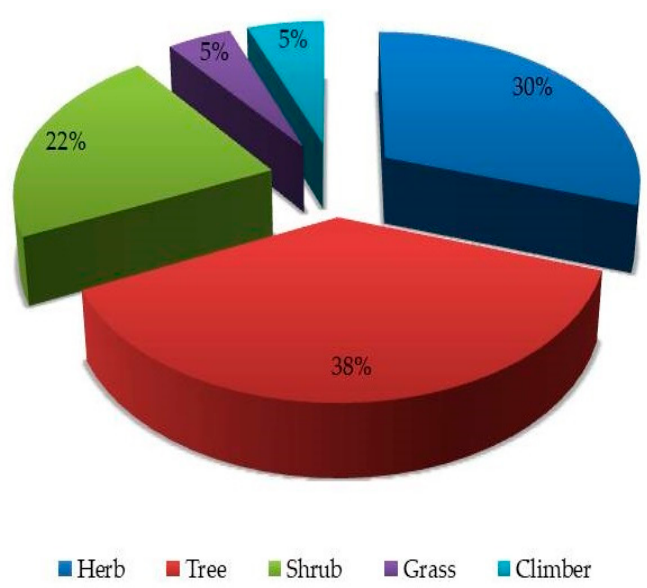
Figure 5. The growth form of medicinal plants documented in this study.